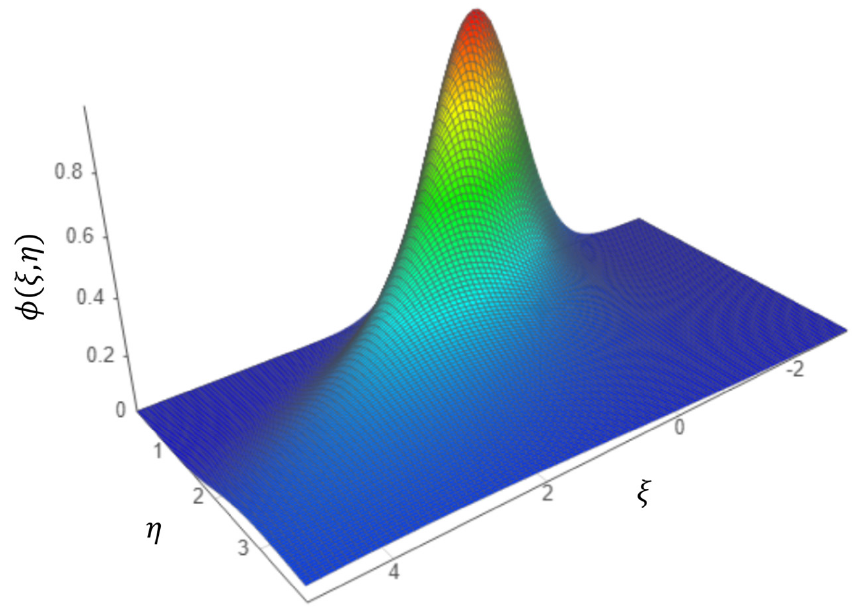
Figure 1. Three ‐ dimensional graphical representations of 𝑉 ( 𝜉 , 𝜂 ) velocity multifractal theoretical Figure 1. Three-dimensional graphical representations of V ( ξ , η ) velocity multifractal theoretical function. function.